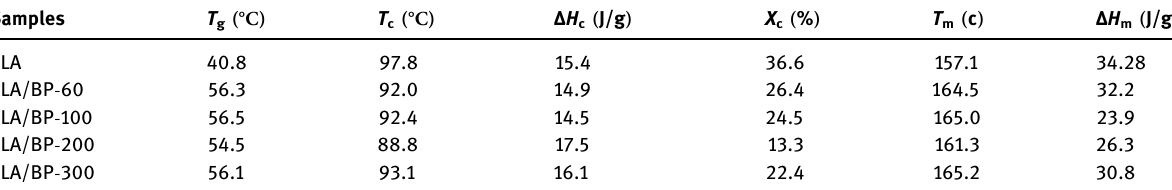
Table 2: Thermal characteristics parameters of PLA/BP biocomposites Samples